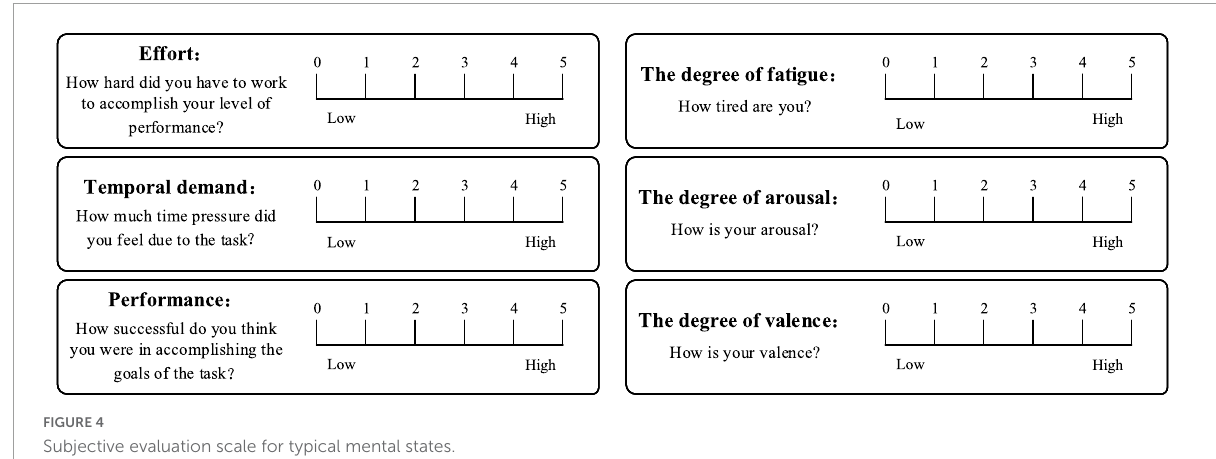
FIGURE4 Subjective evaluation scale for typical mental states.